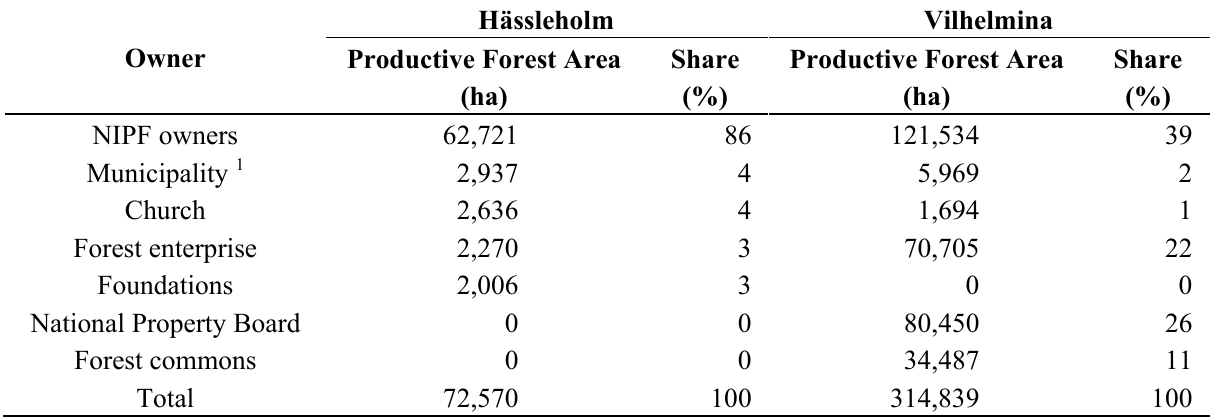
Table 2. Ownership structure in Hässleholm and